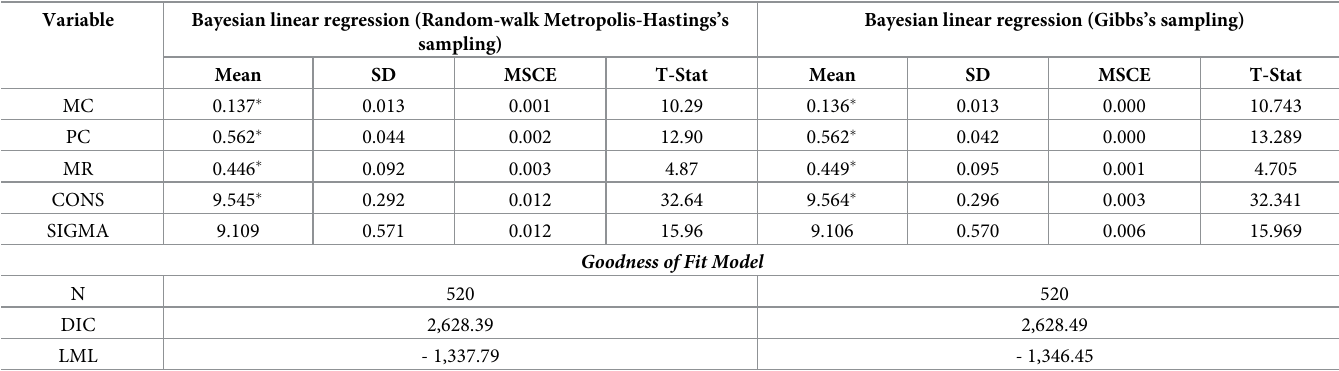
Table 1. Model convergence and estimated